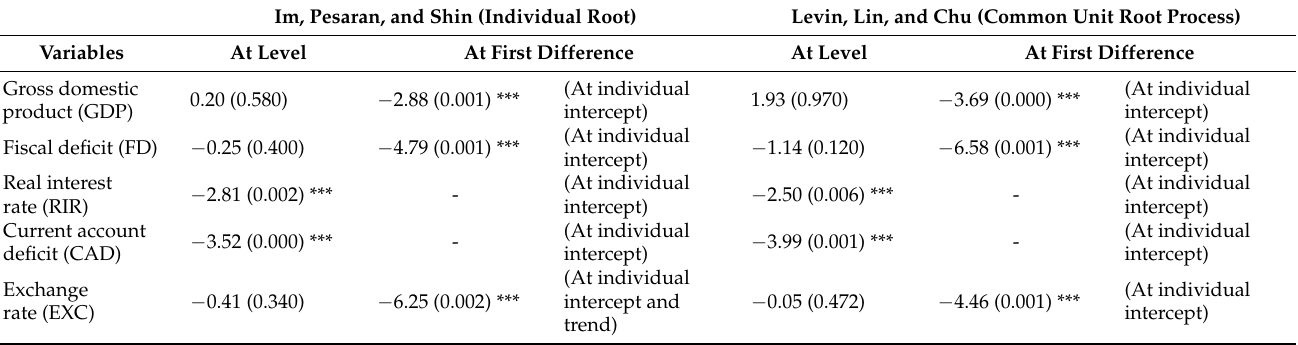
Table 6. Findings of panel unit root testing for upper-middle-income economies